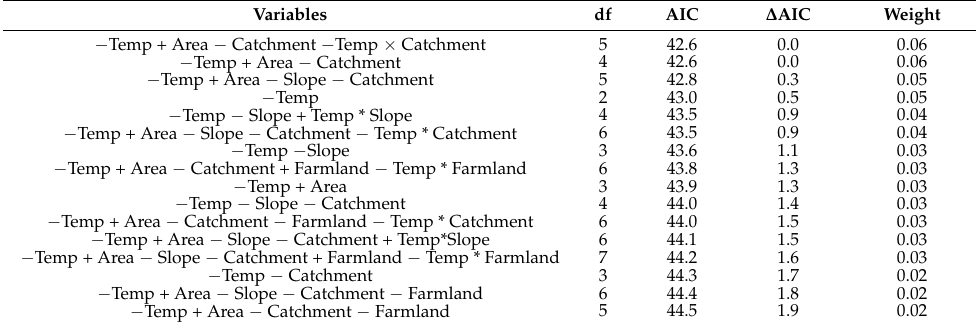
Table 3. Results of model selection for the occurrence analysis. Models with ∆ AIC < 2 are shown. “Temp”, “Area”, “Slope”, “Catchment”, and “Farmland” represent the mean summer water temper- ature, survey area, stream slope, catchment size and proportion of farmland, respectively. “Temp * Slope”, “Temp * Catchment”, and “Temp * Farmland” indicate the interactive terms between the mean summer water temperature and other environmental factors. “df” and “Weight” indicate the degrees of freedom and Akaike weight, respectively. Plus and minus symbols indicate positive and negative estimated coefficients, respectively.